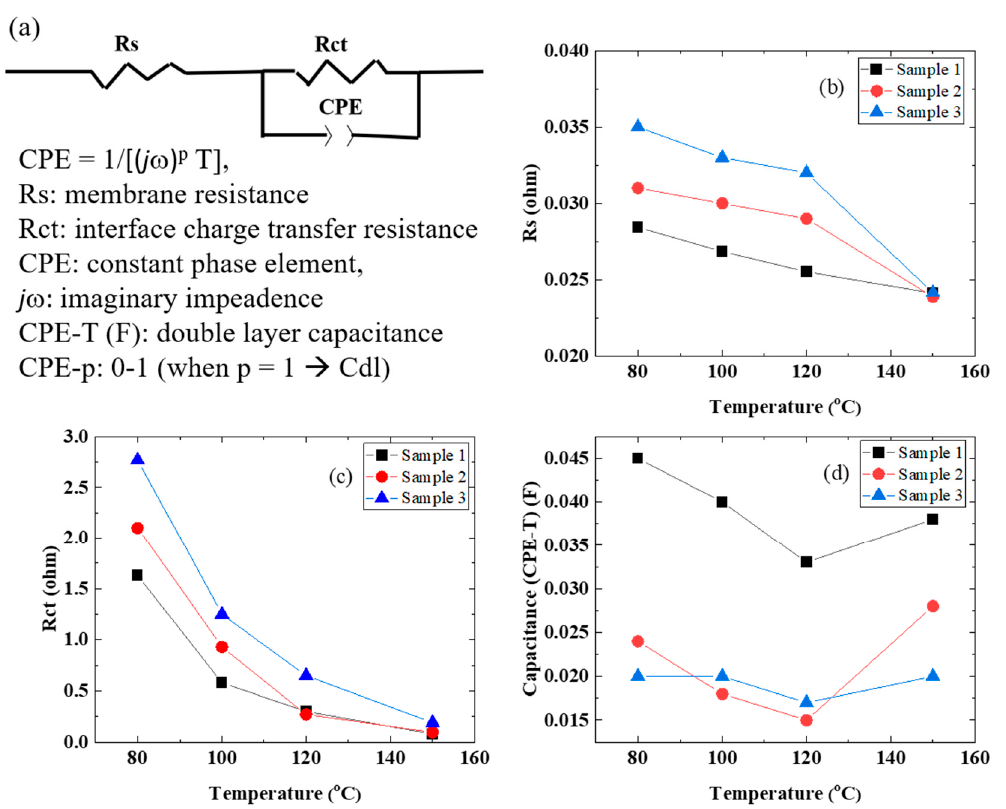
Figure 4. ( a ) The equivalent circuit used to fit the EIS data. ( b ) Ohmic resistance (Rs), ( c ) charge transfer resistance (Rct), ( d ) double layer capacitance (CPE-T) vs. temperature. Table 3. Parameters obtained from EIS data (Figure 3) fitted to the equivalent circuit shown in Figure 4a.